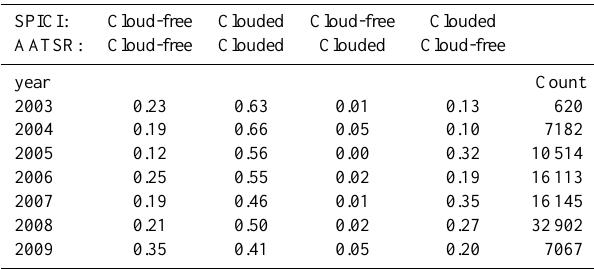
Table 5. Comparison of scene identifications between SPICI and AATSR over time. A total of 91 × 10 3 SPICI observations were compared to co-located averaged AATSR observations. A scenes is considered clouded by AATSR when the average AATSR cloud- fraction over the scenes is more than 10%. The table shows the fraction of the total number of SPICI observations which fall under the catagory indicated in the top of the table. Total number count of SPICI obervations employed for the comparison for each year in the right